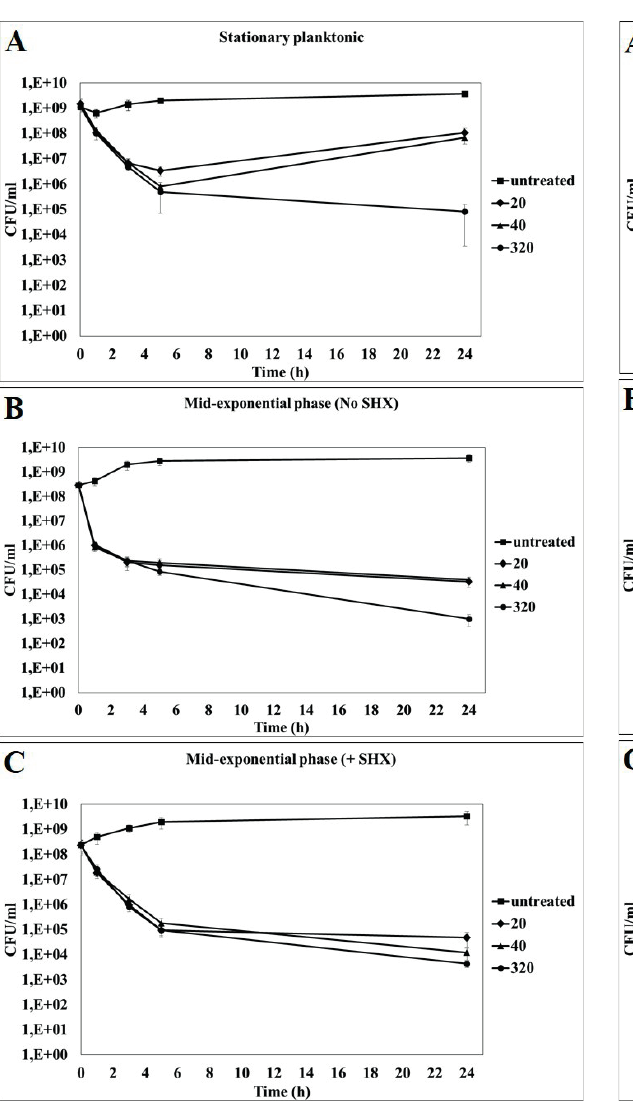
Fig. 5. Killing of P. aeruginosa PAO1 wild-type cells by cipro- floxacin. Cells of stationary-phase (A), exponential-phase without SHX (B) and exponential-phase cultures with SHX (C) were exposed to 3-, 6- and 48-μg/mL of ciprofloxacin (MIC is 0.6 μg/mL) for 1, 3, 5 and 24 h and then plated for colony forming units (CFU/ mL). The percent survival is not shown. The values are averages of three independent experimetns and error bars are not shown, and the error bars indicate the standard error of the